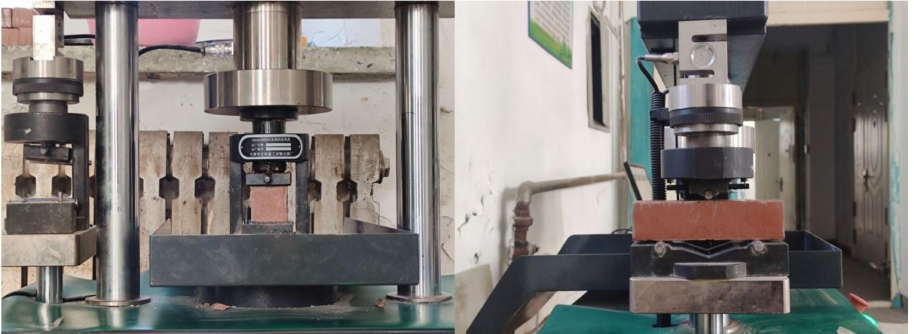
Figure 2. Mechanical properties test chart of a